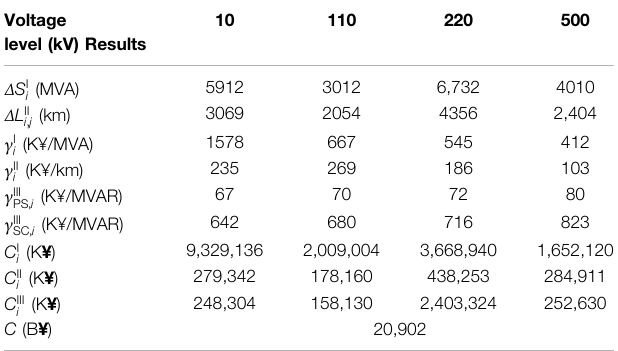
TABLE 1 | The assessment results based on multi-level investment demand assessment model Voltage level (kV) Results